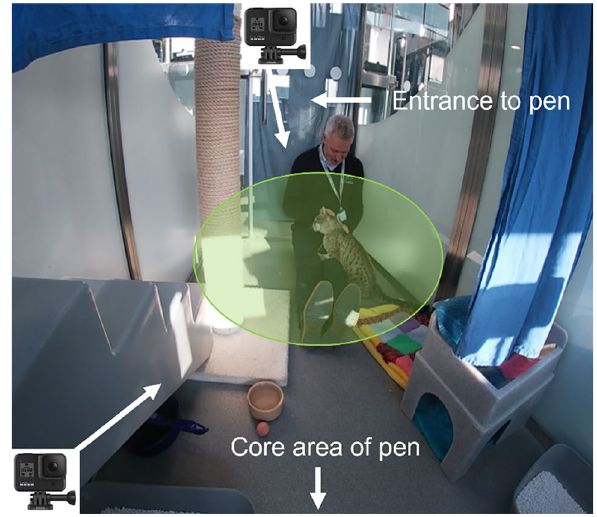
Figure 1. Image captured from GoPro footage depicting experimental set up within an individual cattery pen, including the approximate placement of cameras and their angle of focus (white arrows), the location and typical posture of participants during the test period, and the area within which the cat would be considered as ‘within reach’ of participants (shaded green area, see ethogram in Supplementary File S2 for further